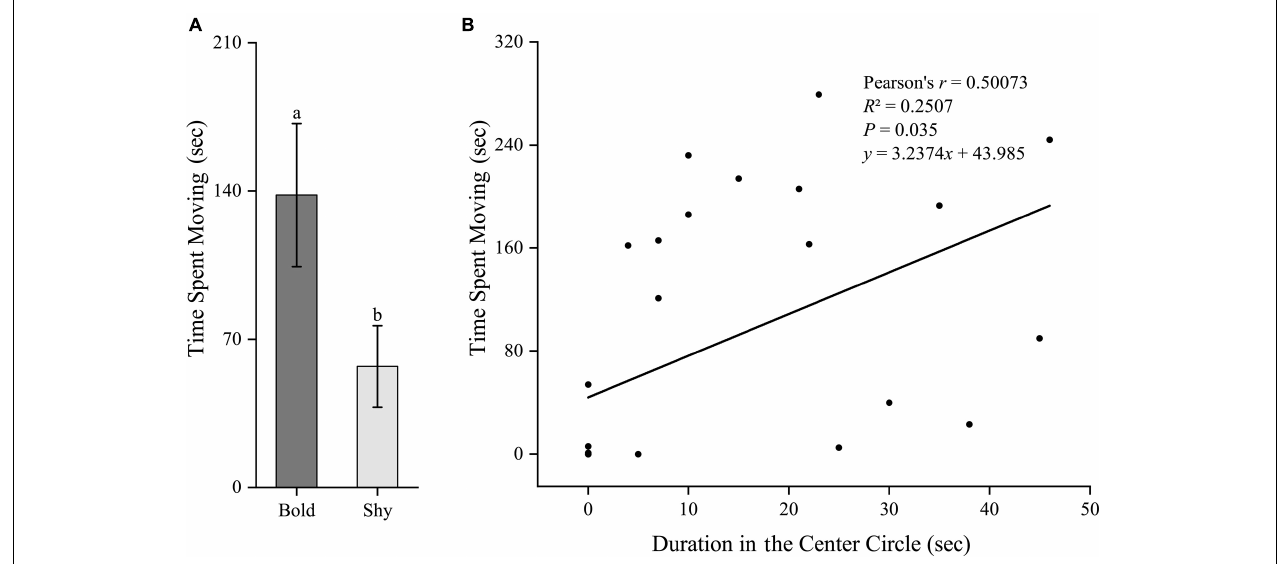
FIGURE 6 | The boldness and stressed locomotor activity of black rockfish. (A) The time spent moving (under stressed condition) in bold ( n = 9) and shy ( n = 20) groups. Different letters indicate significant differences ( P < 0.05; independent samples t -test). (B) Linear fit of the time duration in center circle (open-field boldness test) and the time spent moving (under stressed condition) ( n = 29).